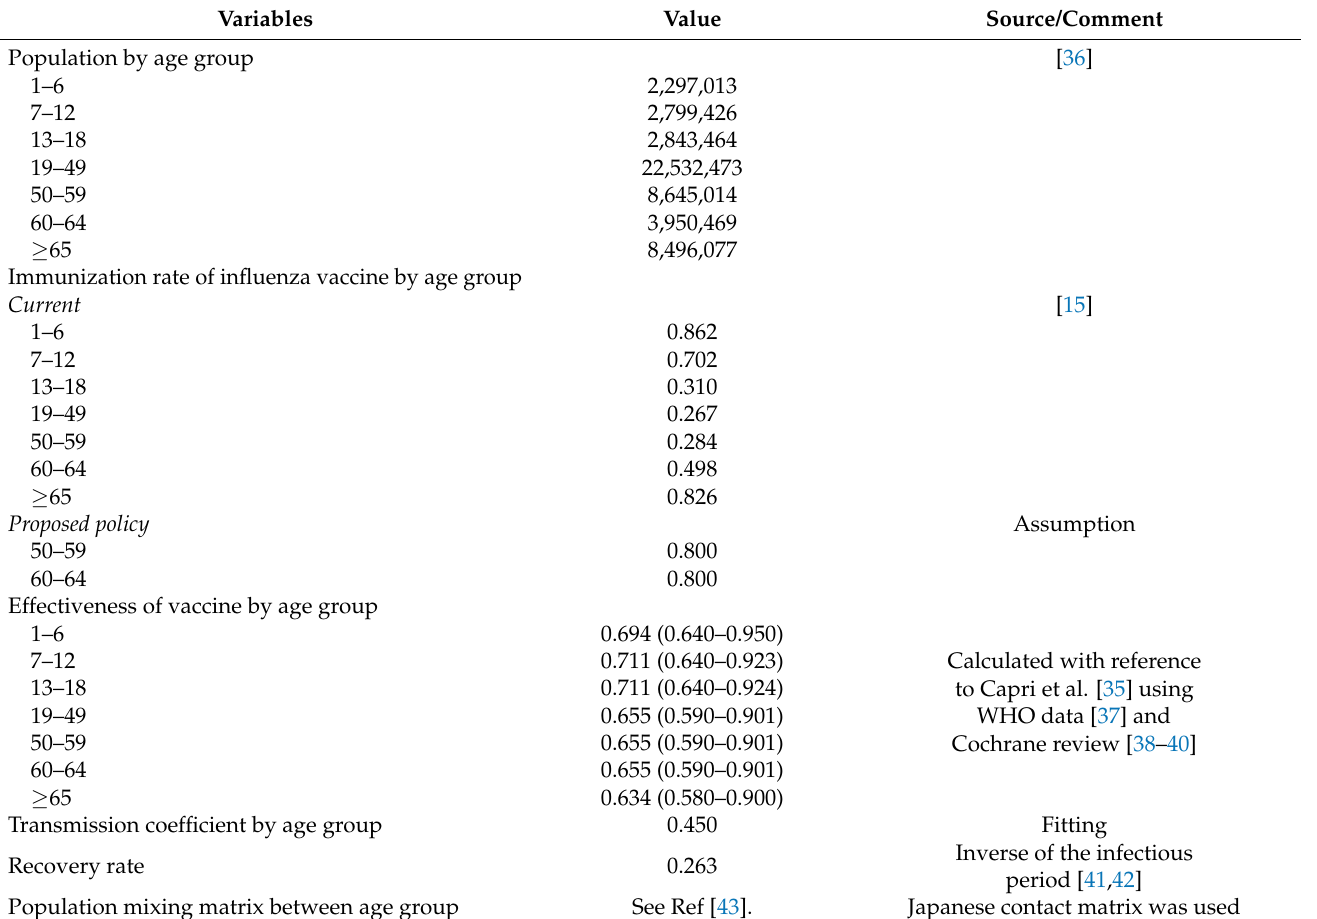
Table 1. Population and vaccination